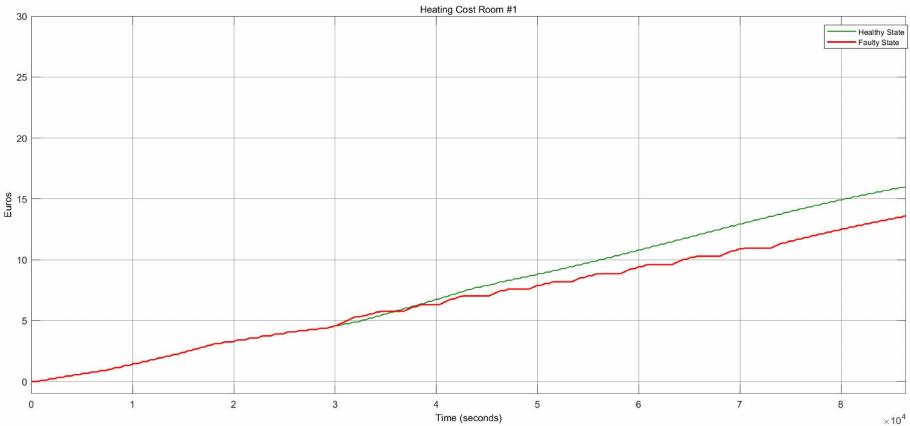
Figure 19. Heating cost variations for the healthy and faulty states of the HVAC system in the case of an intermittent fault with ten